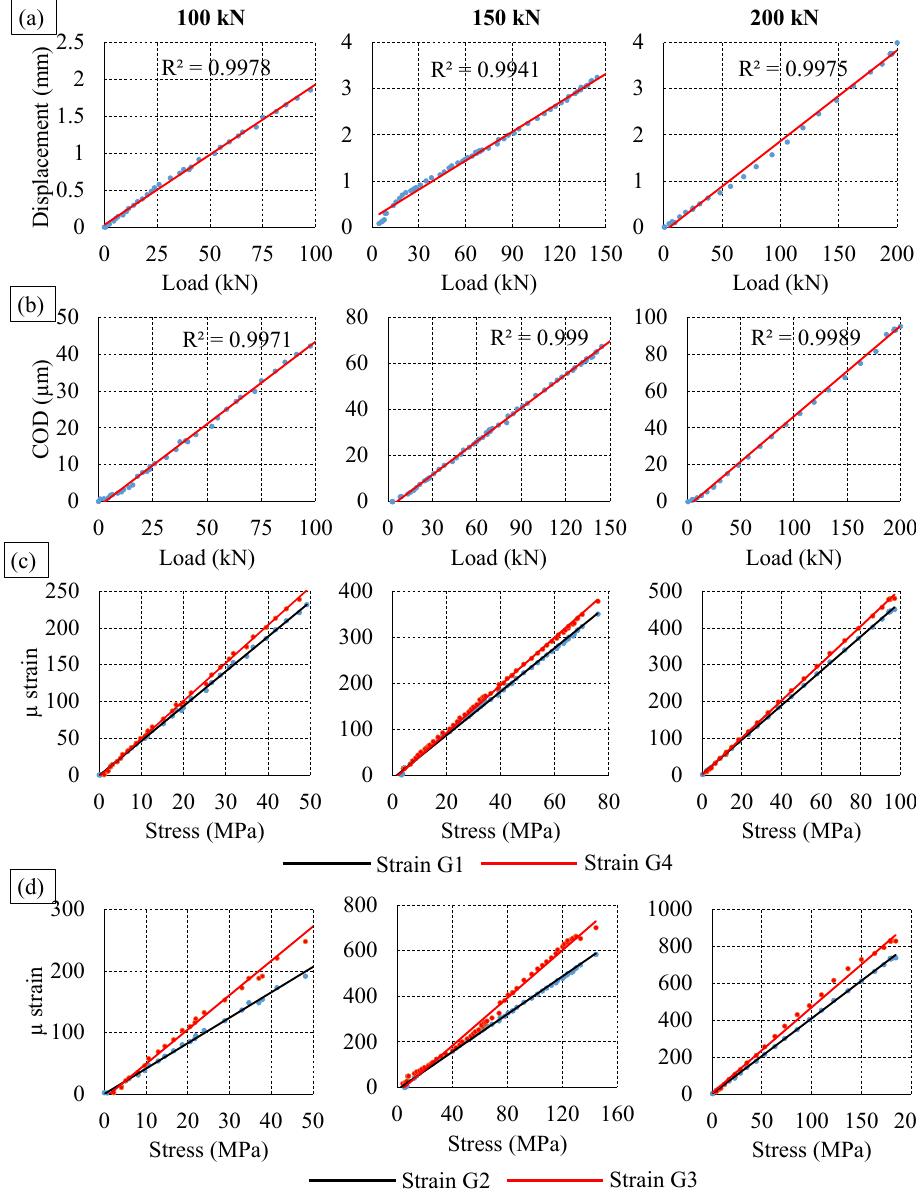
Figure 7. Experiment results ( a ) Vertical displacement ( b ) Crack opening displacement ( c ) Strain at far strain gauge ( d ) Strain at near strain gauge.